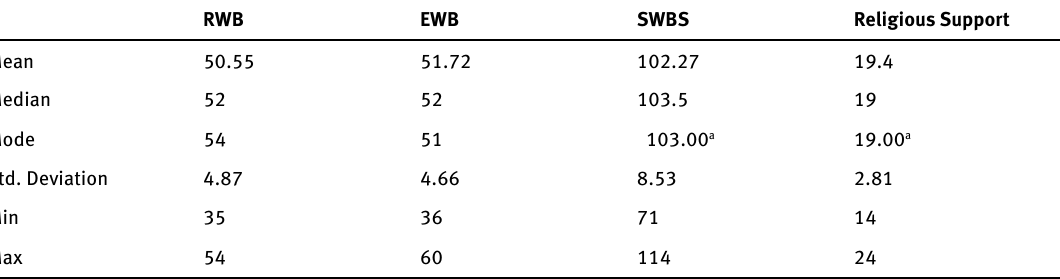
Table 5: Spiritual Well-Being Scale Statistics ( N =40) RWB EWB SWBS Religious Support Mean